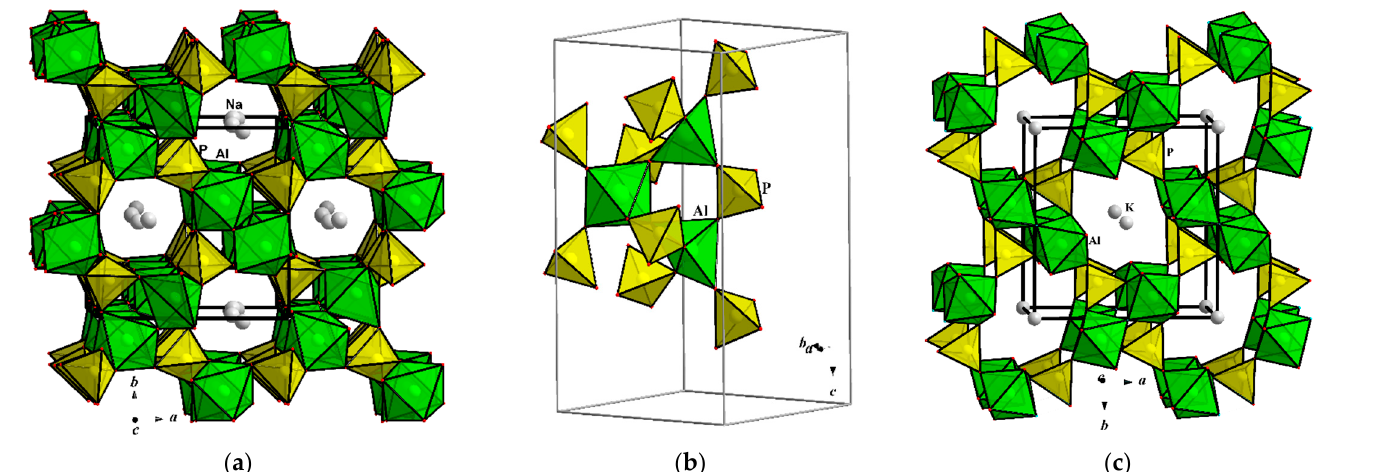
Figure 6. Crystal structures of Na 2 Al 3 (OH) 2 (PO 4 ) 3 ( a ) and minyulite ( c ) projected along the c axis of their pseudo tetragonal unit cells; ( b ) fragment of the Na 2 Al 3 (OH) 2 (PO 4 ) 3 structure showing the horseshoe-like cluster built from the AlO 4 (OH) 2 octahedron and two AlO 4 (OH) five-vertex polyhedra.